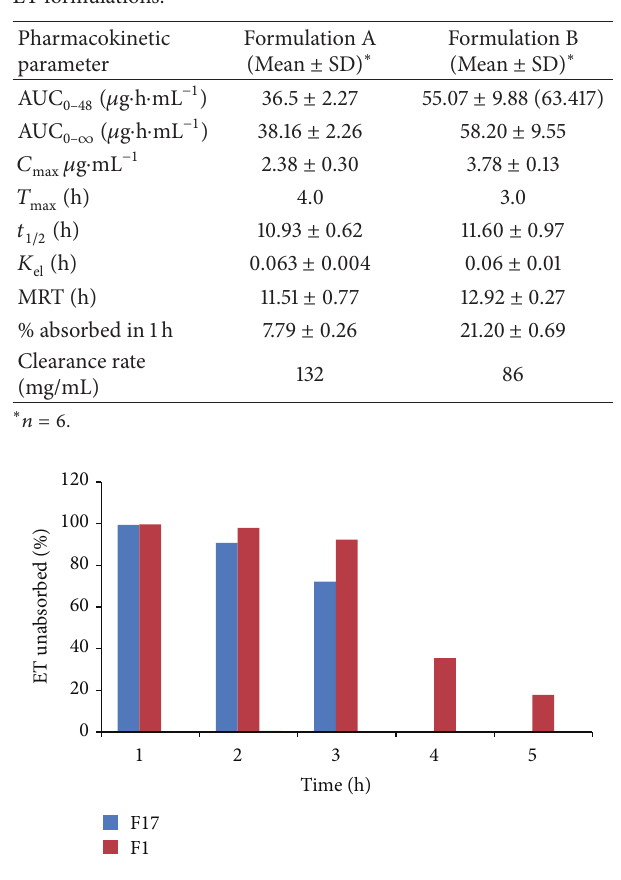
Figure 8: Percentage ET unabsorbed versus time for the two formu- lations F1 (Pure ET suspension) and F17 (ET